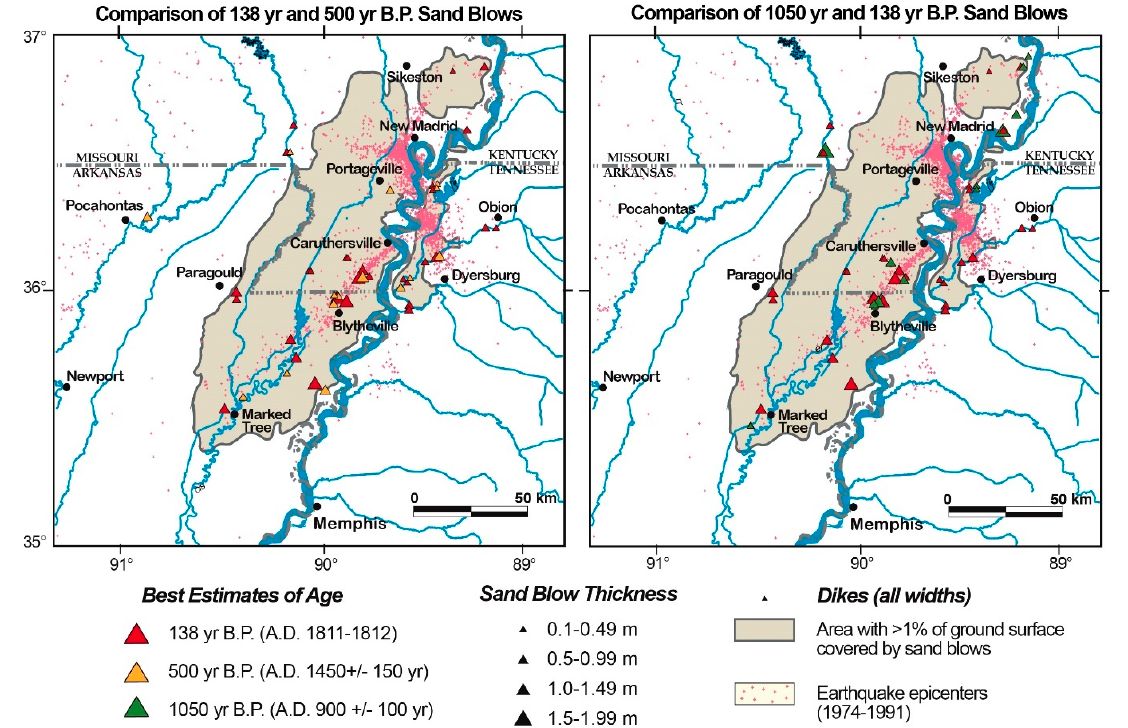
Figure 19. Maps of the New Madrid seismic zone showing comparison of sizes and spatial distributions of sand blows and dikes that formed during the 138 years BP (AD 1811–1812) event with those attributed to the events 500 years BP (AD 1450) and 1050 years BP (AD 900) (modified from Reference [6]).